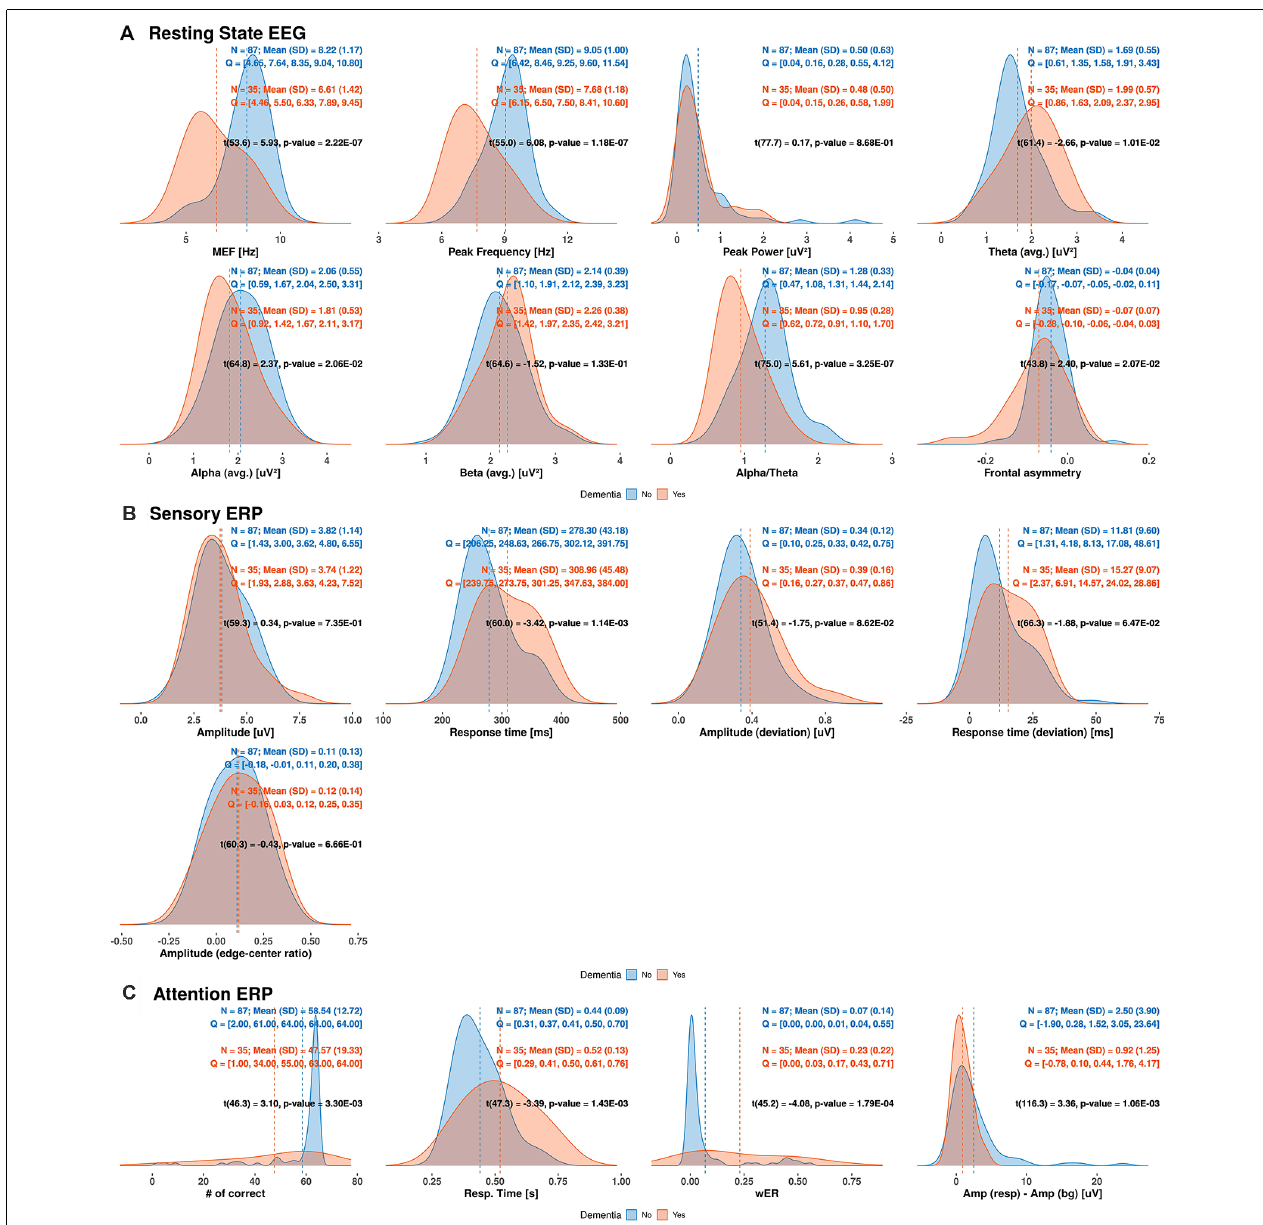
FIGURE 3 | Estimated densities of EEG/ERP variables in dementia and non-dementia subjects. Q indicates values divided into four quantiles (MEF, median frequency; wER, weighted error percentile; SD, standard